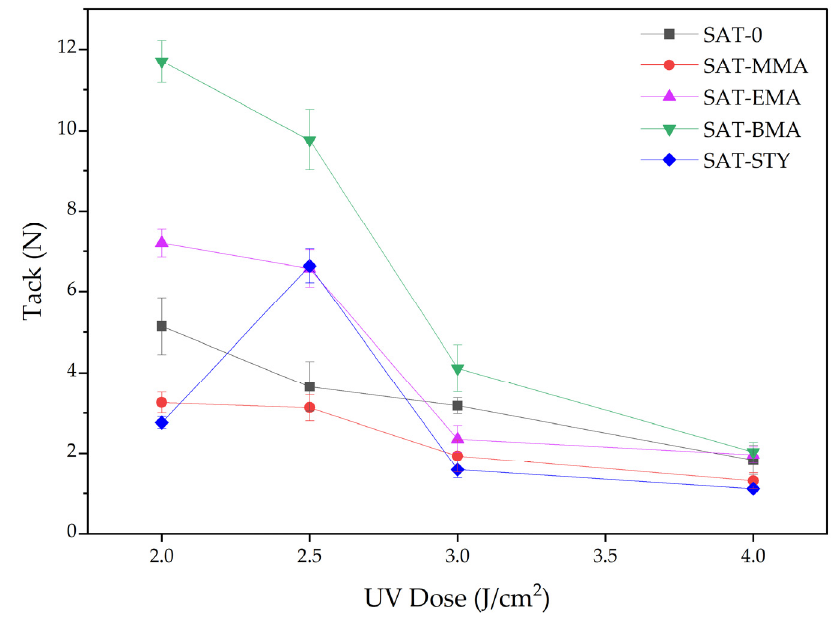
Figure 8. Tack to steel of UV-crosslinked SATs.